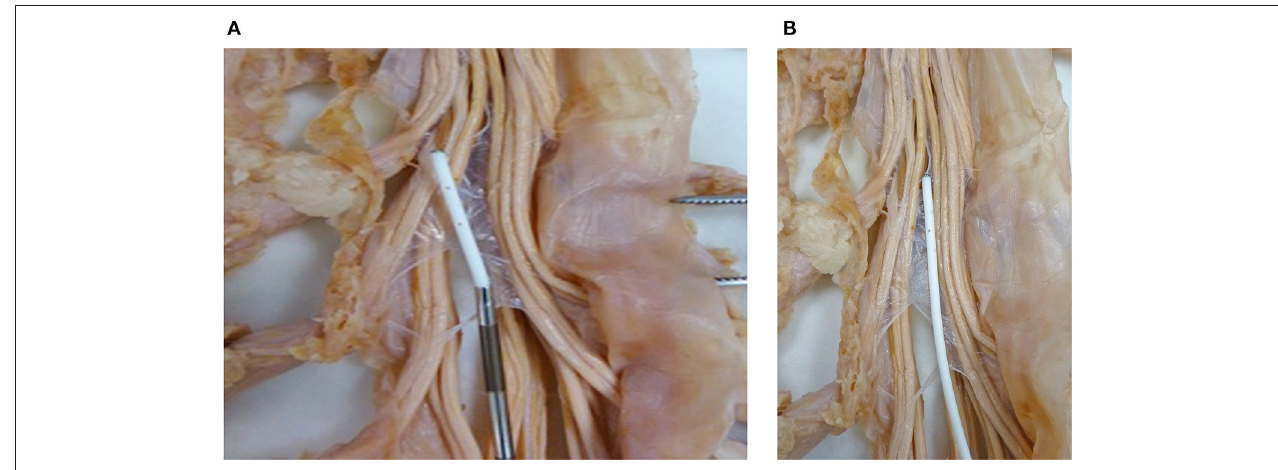
FIGURE 6 | (A) Subarachnoid catheter. A catheter exiting the introducer needle in the vicinity of the roots of the cauda equina. (B) A catheter in the subarachnoid space to visualize the size relationship with respect to roots of the cauda